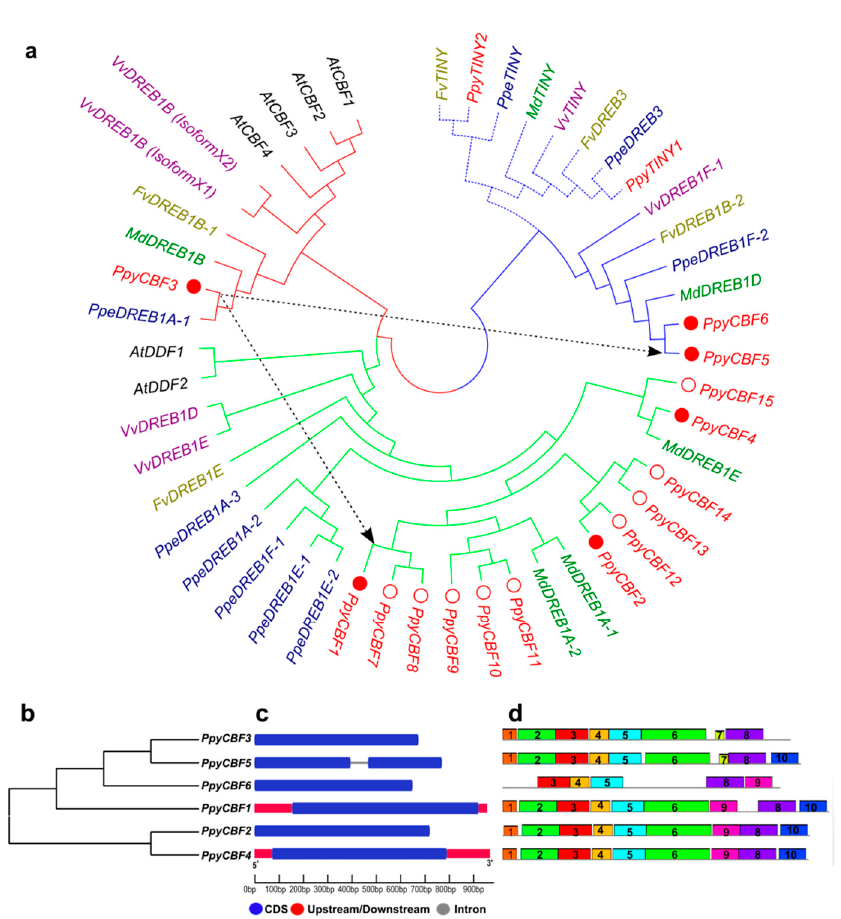
Figure 1. Identification and characterization of PpyCBFs . ( a ) Phylogenetic analysis of PpyCBF transcription factors with similar TFs of Arabidopsis ( At ), Malus ( Md ), Prunus ( Ppe ), Fragaria ( Fv ), and Vitis ( Vv ) species. Red, green, and blue colors indicate clades / subtypes I, II, and III of CBFs, respectively, while compact and hollow red circles indicate selected and rejected PpyCBFs , respectively. Arrow lines indicate the evolution of clades II and III from clade I. ( b ) Phylogenetic analysis of selected PpyCBFs . ( c ) Gene structure of PpyCBFs . Blue, black, and red lines indicate exon, intron, and upstream / downstream sections in gene structure. ( d ) Protein motif: Schematic diagrams of possible conserved motifs (1–10) in PpyCBF proteins, indicated by different colors.